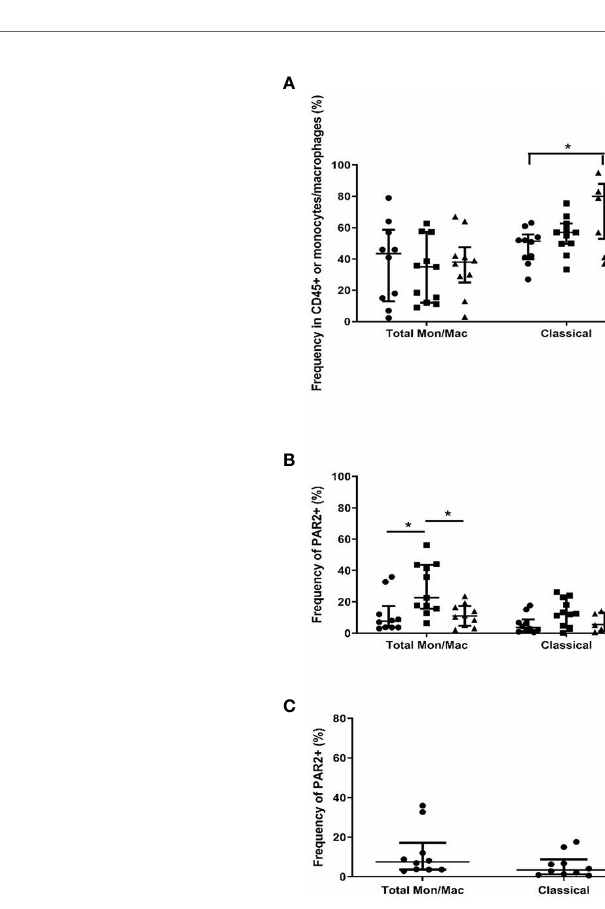
FIGURE 2 | Identi fi cation of speci fi c monocyte/macrophage subtypes and their expression of PAR2 in SF of PsA, OA and RA patients. Flow cytometry was used to determine the total (A) and PAR2-expressing (B) monocytes/macrophages from SF of PsA, OA and RA patients (n=10 each). Classical (CD14+CD16-) monocytes/ macrophages are elevated in RA compared to PsA (p=0.030) while intermediate (CD14+CD16+) cells are higher in PsA compared to RA (p=0.038). PAR2 expression is increased in OA compared to PsA (p=0.014) and RA (p=0.046) patients and is expressed predominantly in cells with an intermediate phenotype (p=0.008). No signi fi cant differences are observed in PAR2 expression between cell subpopulations of PsA SF cells (C) . Populations were compared using the Kruskal-Wallis test with Dunn ’ s multiple comparisons test. Asterisks are used to indicate signi fi cant differences between groups, where *p<0.05 and